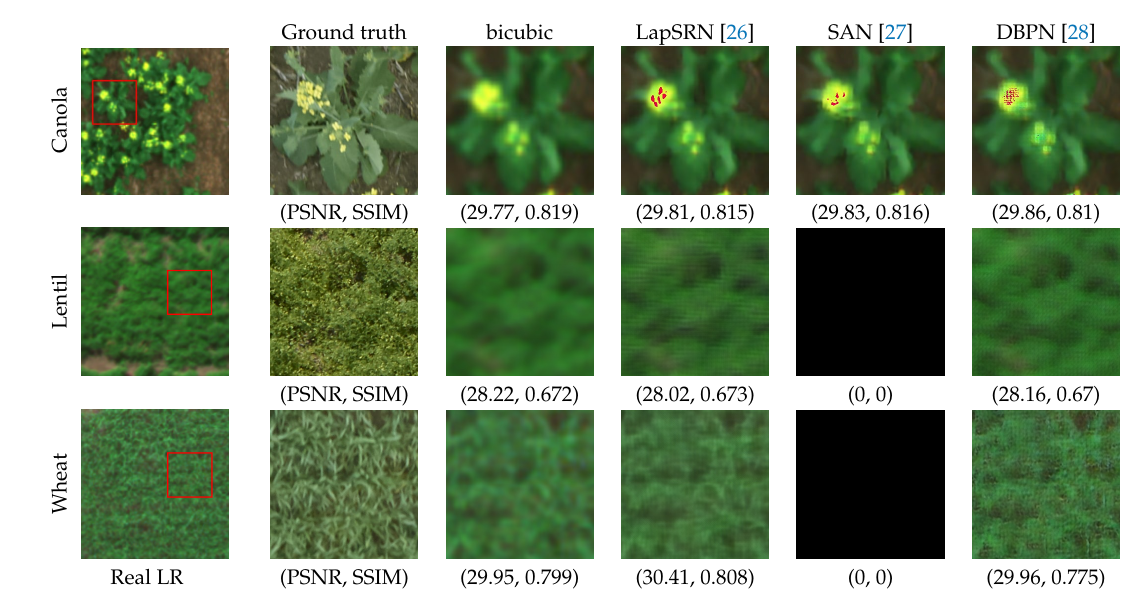
Figure 5. Example test images from the synthetic-real experiment for canola, lentil and wheat datasets (top/middle/bottom rows). Ground truth HR images (left) are shown with the cropped region denoted by a red box. PSNR and SSIM values are listed below each image. Black images for SAN denote that the model failed to converge when trained on the lentil and wheat datasets.